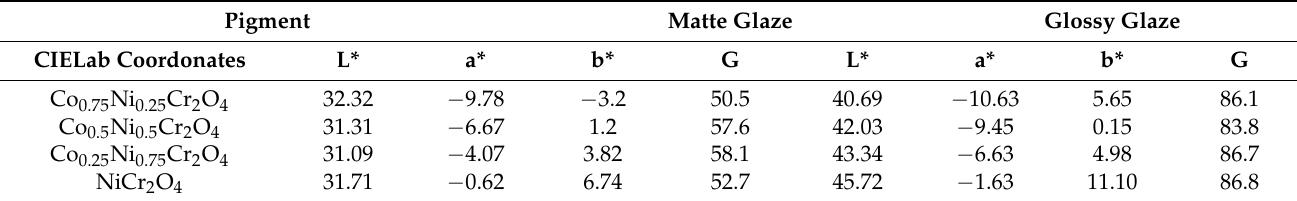
Figure 9. The Co (1 − x) Ni x Cr 2 O 4 pigment Nano powders before after their embedding in matte and glossy glaze. Table 4. The CIELab coordinates of pigments embedded in opaque tile